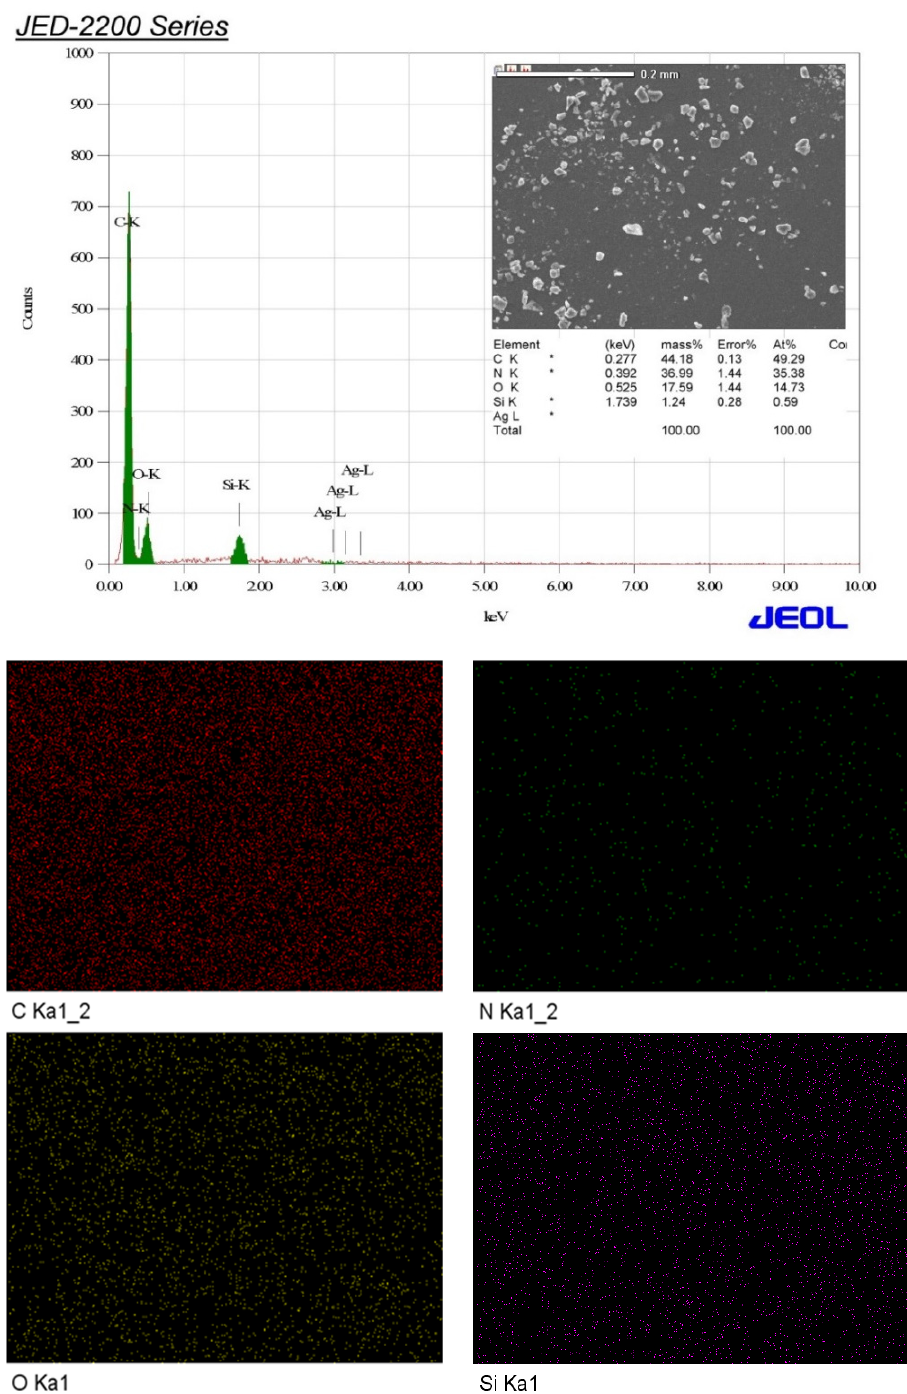
Figure 5. SEM -EDX with elemental mapping of CPEEUA/FS-40 to assess morphology.